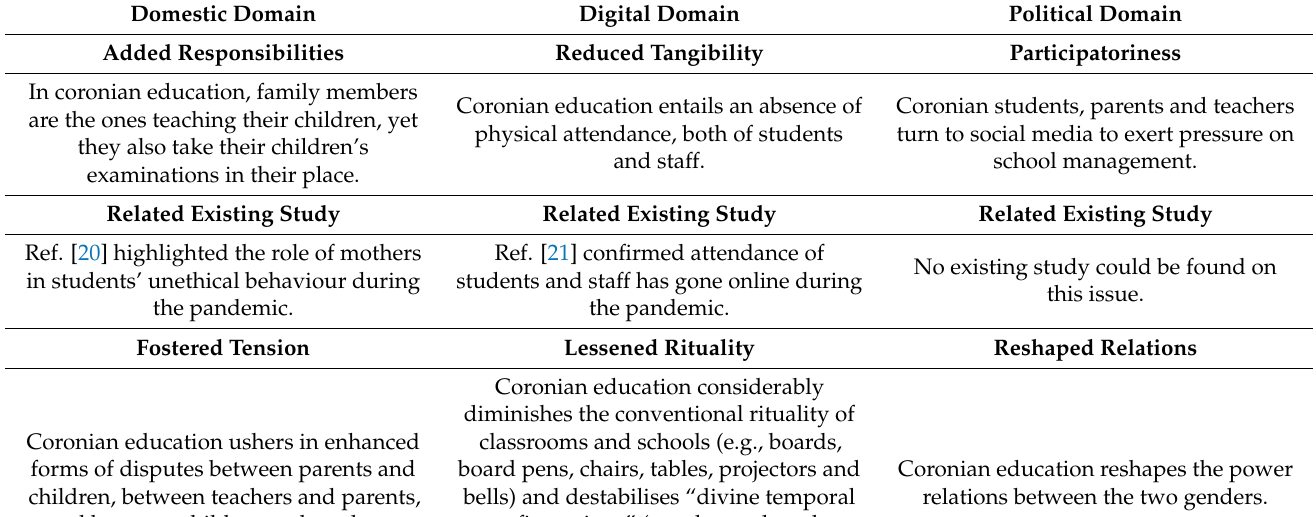
Table 2. Summary of